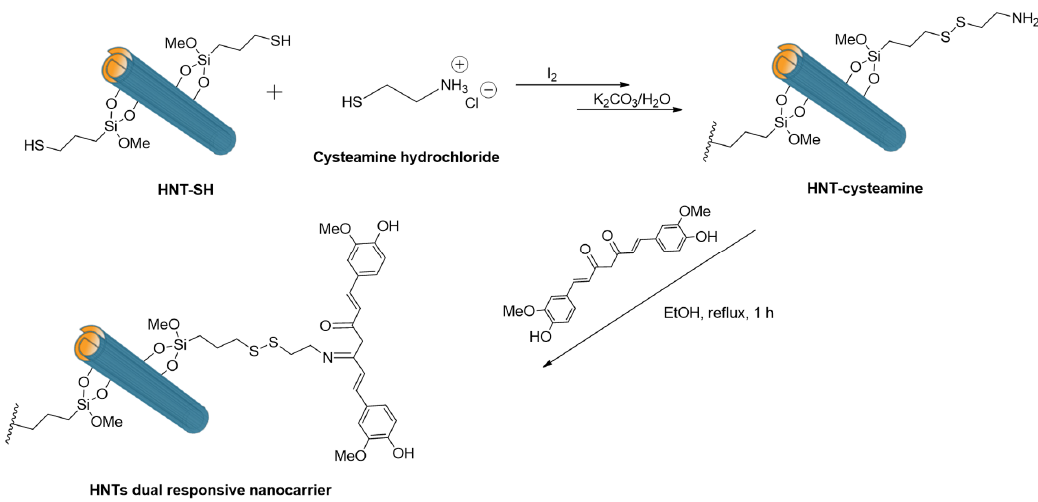
Figure 15. Schematic representation of the synthesis of the dual responsive nanocarrier based on HNTs.